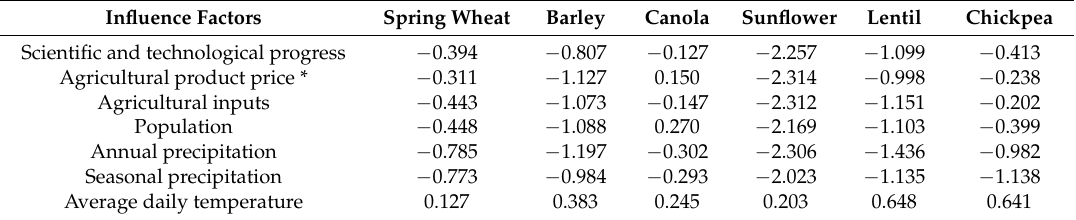
Table 4. Path coefficient analysis between protein yield-based water footprints (WFs) and their influencing